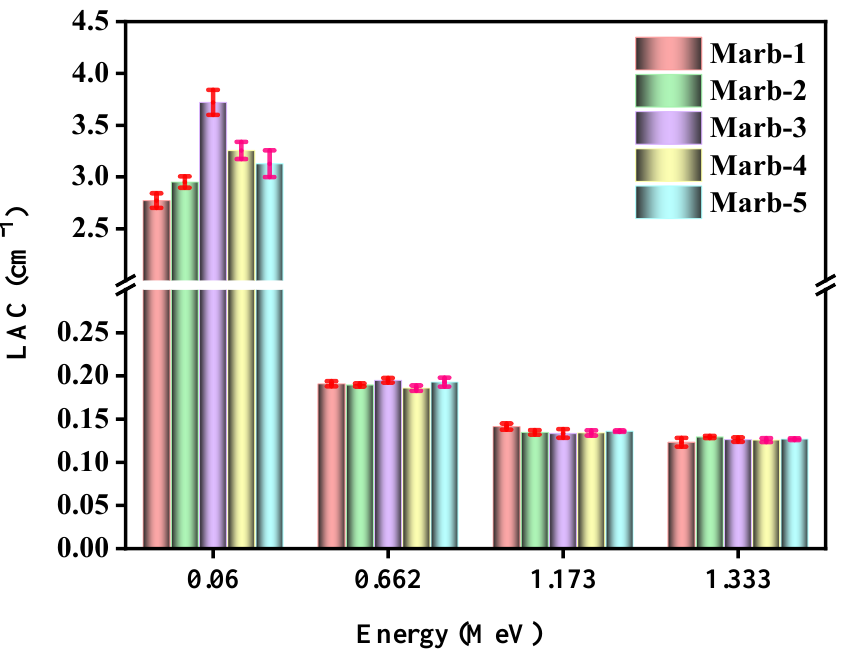
Figure 3. The demonstration of LAC of the prepared composites at energy 0.06 MeV, 0.662 MeV, 1.173 MeV, and 1.333 MeV.